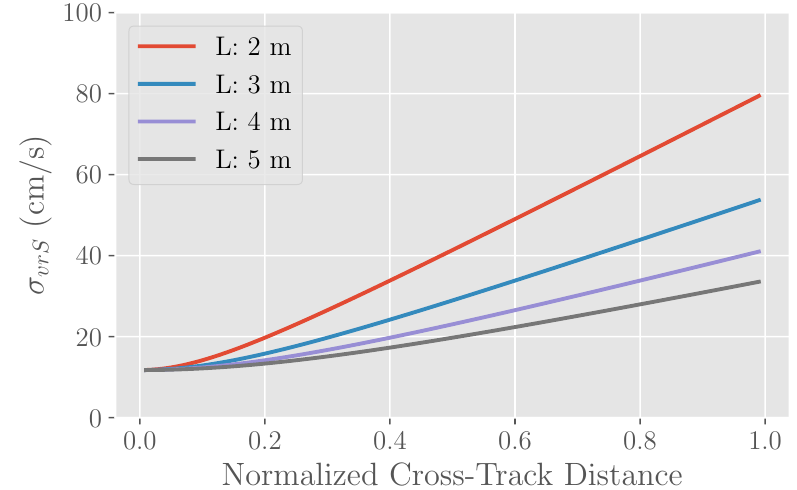
Figure 10. Surface projected radial velocity error as a function of normalized cross-track distance from nadir for a peak output power of 100 W and varying antenna length, L . This performance assume only one pencil beam.